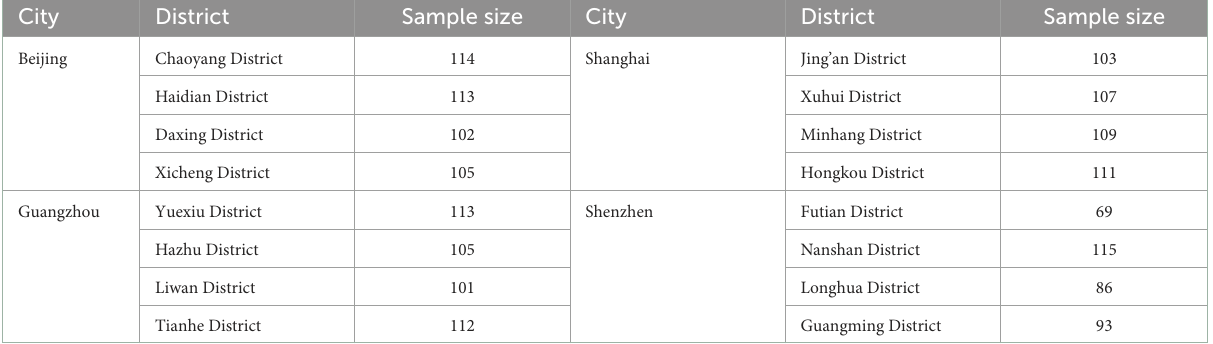
TABLE 1 Regional distribution of the sample. City District Sample